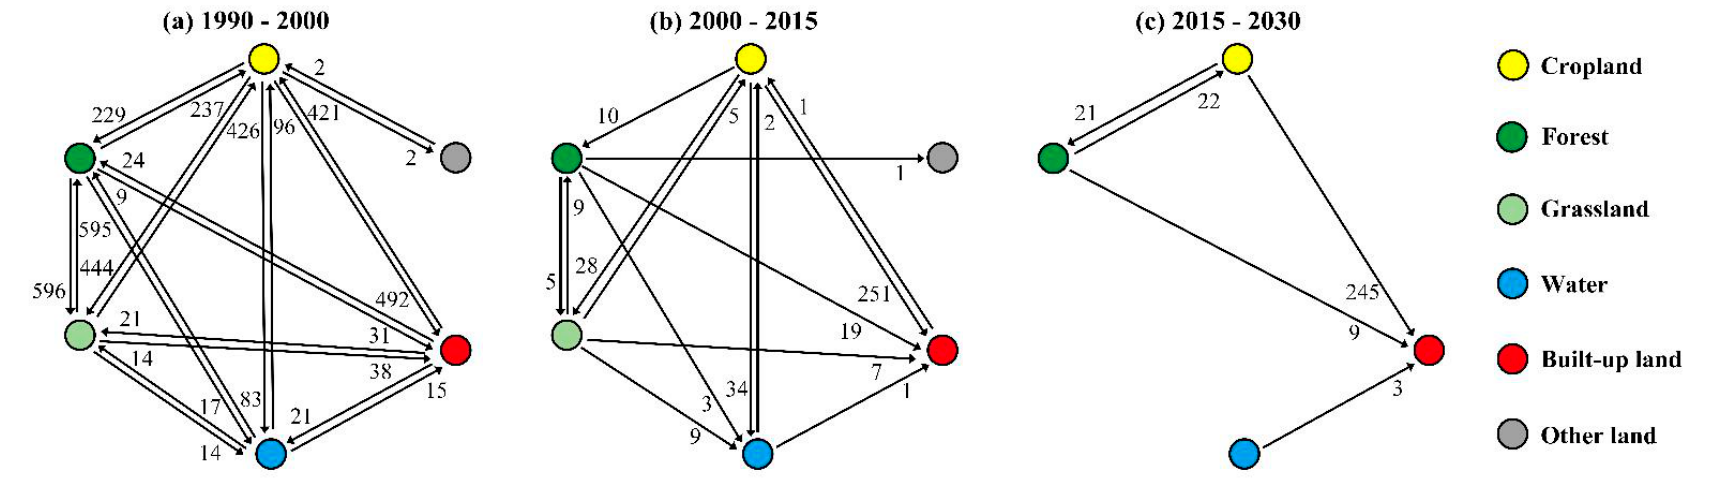
Figure 12. Complex network of the land use change in Xi’an city.